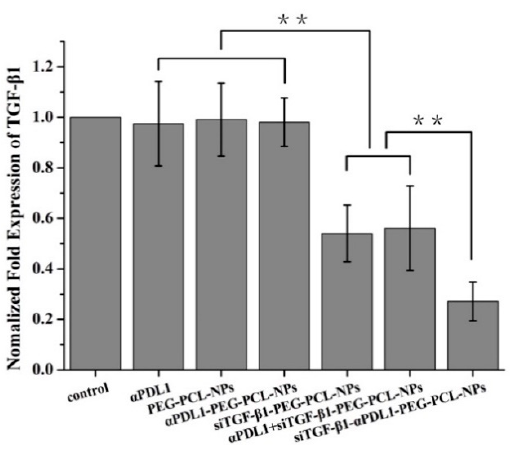
Figure 9. Expression of TGF- β 1 in tumor tissue samples from TGF- β 1 + MFC mice after different treatments (from up to down: saline control, PEG-PCL-NPs (NPs), α PDL1, α PDL1-NPs, siTGF- β 1- PEG-PCL-NPs, α PDL1 + siTGF- β 1-PEG-PCL-NPs and α PDL1-siTGF- β 1-PEG-PCL -NPs) after 6 weeks. The expression of TGF- β 1 was normalized to the U6 small nuclear RNA gene (U6 snRNA) control. Compared with the saline control group, the expression levels of TGF- β 1 in the PEG-PCL-NPs (NPs), α PDL1, α PDL1-NPs, siTGF- β 1-PEG-PCL-NPs, α PDL1 + siTGF- β 1-PEG-PCL-NPs and α PDL1-siTGF- β 1- PEG-PCL-NPs groups were 0.98-fold ( p > 0.05), 0.99-fold, 0.98-fold, 0.52-fold, 0.56-fold and 0.27-fold (siTGF- β 1, Transforming Growth Factor- β 1 siRNA; NPs, nanoparticles; α PDL1, anti-programmed cell death-Ligand 1; ** p < 0.01).